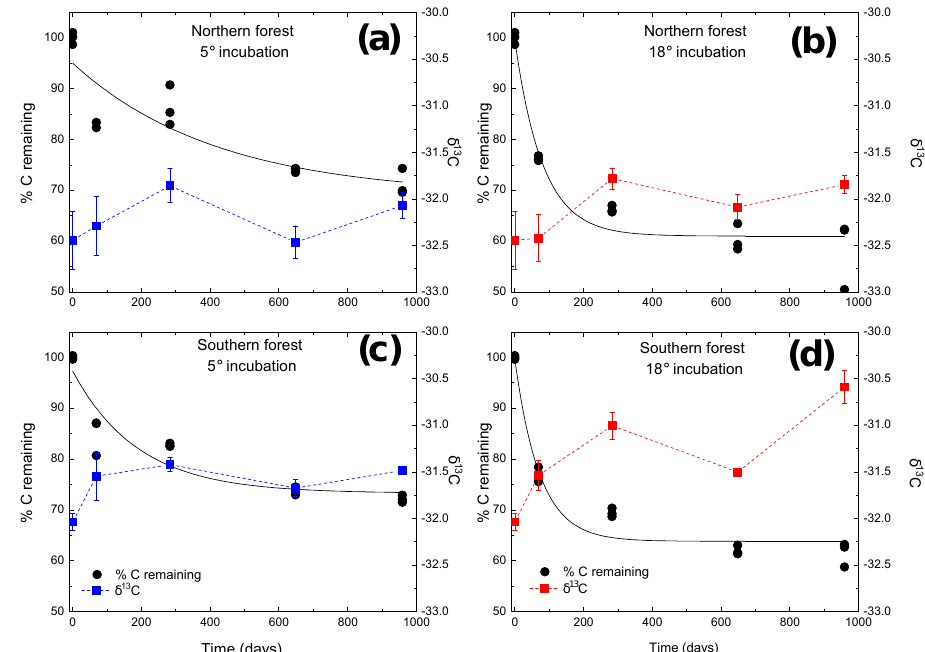
Figure 1. Moss tissue C remaining normalized to the initial tissue C (black circles). The solid black line represents the exponential fit used to assess the decay constant ( k ). The δ 13 C values for the moss tissue at each time are indicated by squares and dashed lines, reported as the mean ( n = 3) with the standard error depicted by error bars. Panels (a) and (c) depict (blue lines and symbols) results of the 5 ◦ C incubation, and panels (b) and (d) depict (red lines and symbols) the 18 ◦ C